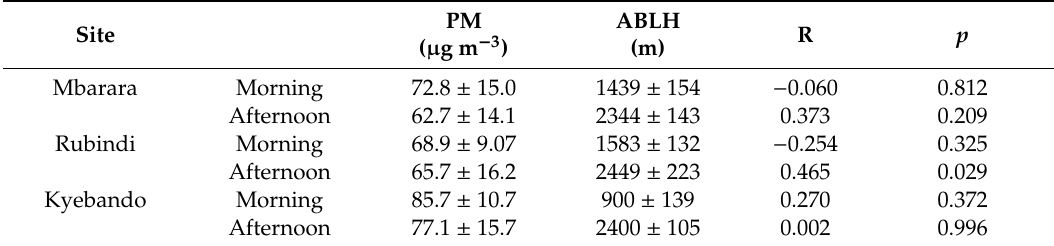
Table 3. E ff ect of MODIS estimated ABLH on PM 10 mass concentration at selected sites. R is the correlation coe ffi cient and p is the p -value of the correlation, with values under 0.05 considered to be